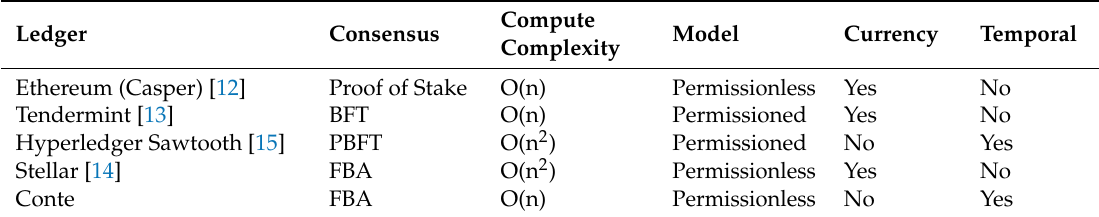
Table 1. Comparison of selected blockchain distributed ledger